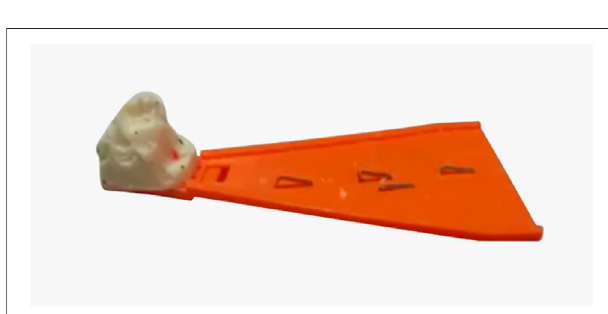
FIGURE 3 | A baiter-holder (the orange object) with an attached WaxTag ® (the white object on the left) showing a possum ’ s dental